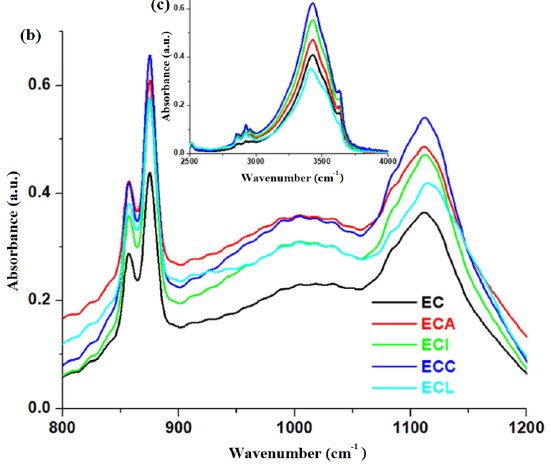
Figure 5. FTIR spectra of expired cement and composite-expired cement materials in the region between ( a ) 400 and 1600 cm − 1 , ( b ) 800 and 1200 cm − 1 , and ( c ) 2500 and 4000 cm − 1 performed at 28 days after their preparation.